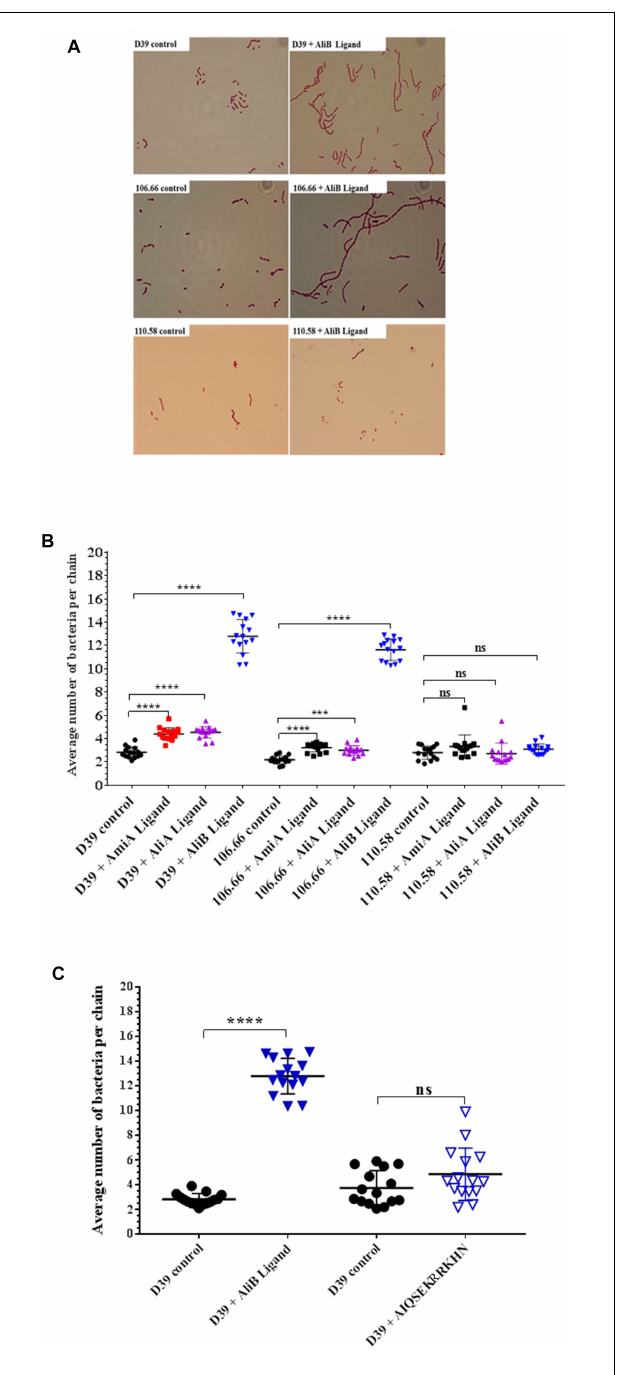
FIGURE 4 | Effect of peptides on pneumococcal chain length. In CDM, strain D39 and its mutants, 106.66 and 110.58 were grown to OD 600nm = 0.2 in the absence and presence of peptide ligands (0.5 mg/mL). (A) Representative brightfield images showing differences in chain length between controls and S. pneumoniae treated with AliB peptide ligand. (B) Quantification of results with all peptides and (C) comparison of effect of AliB ligand with that of a peptide with a single amino acid substitution (AIQSEKRRKHN) on chain length of strain D39. Results are presented as mean ± SD of average number of bacteria per chain. Each symbol represents an image containing between 5 and 78 chains. ∗∗∗ p = 0.00021; ∗∗∗∗ p = 0.0001; ns, not